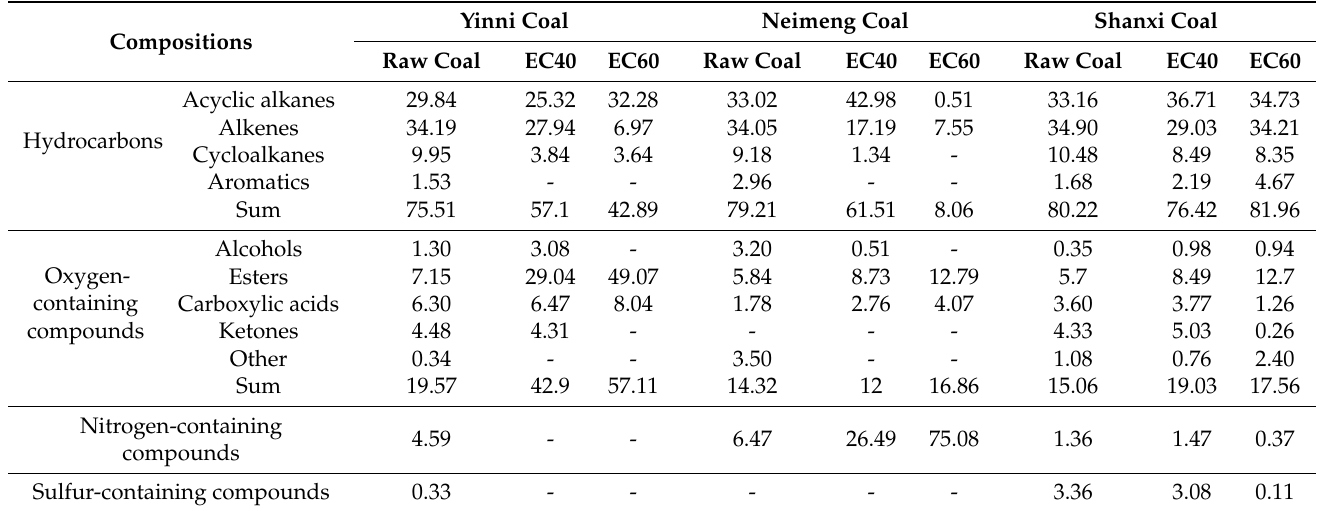
Figure 5. Total ion chromatograms of extracts from Shanxi coal. Table 3. Compositions of Sc-CO 2 extracts from experimental coal samples (%).